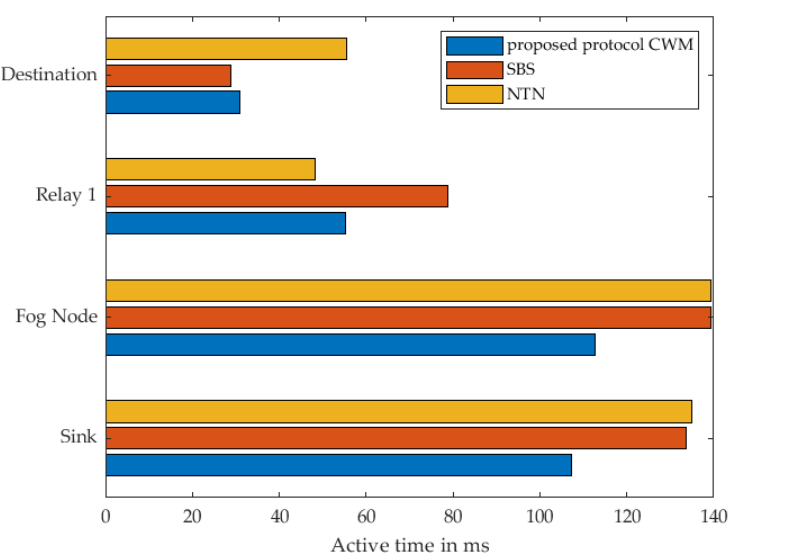
Figure 11. Measured energy consumption of every single node using 1 Relay.